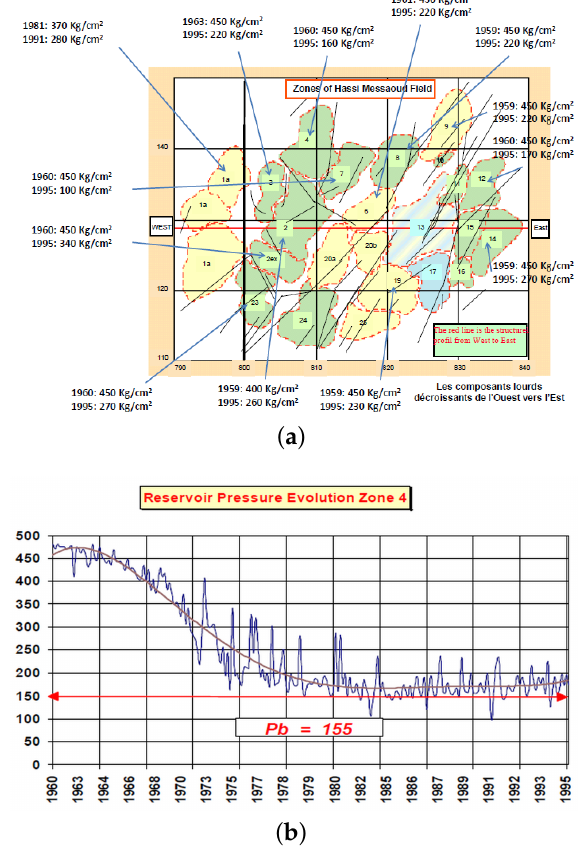
Figure 2. Pressure distribution at the Hassi Messaoud Field: ( a ) Pressure distribution for different zones and ( b ) Pressure evolution along the years for Zone 4. The online pressure evolution is depicted in blue, and this curve’s fitting is shown in red